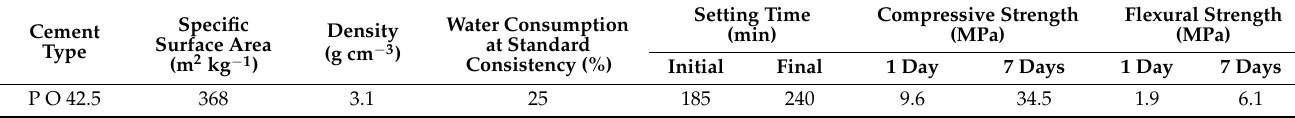
Table 2. Physical properties of cement. Table 3. Physical properties of aggregates.